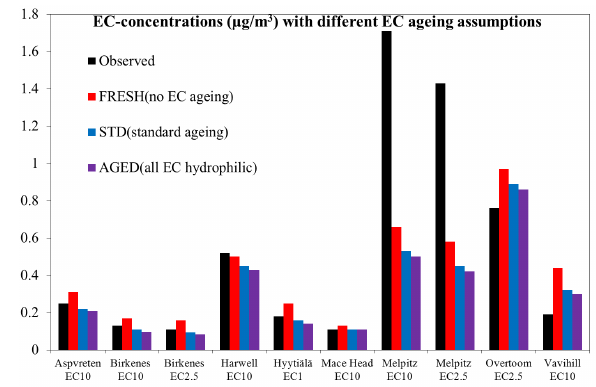
Fig. 6. Comparison of observed EC to model results from simulations using three different assumptions regarding the EC hygroscopicity and atmospheric ageing. The diagram shows average EC concentrations for the periods with measurements: Observed (black); FRESH=Model with all EC treated as externally mixed and hydrophobic, no ageing (red); STD=Standard model version, including atmospheric ageing of EC (blue); AGED=Model with all EC treated as hydrophilic already at emission (purple); unit: μg m -3 . Note that data are from different periods for different stations (see Tables 1 and S2a).